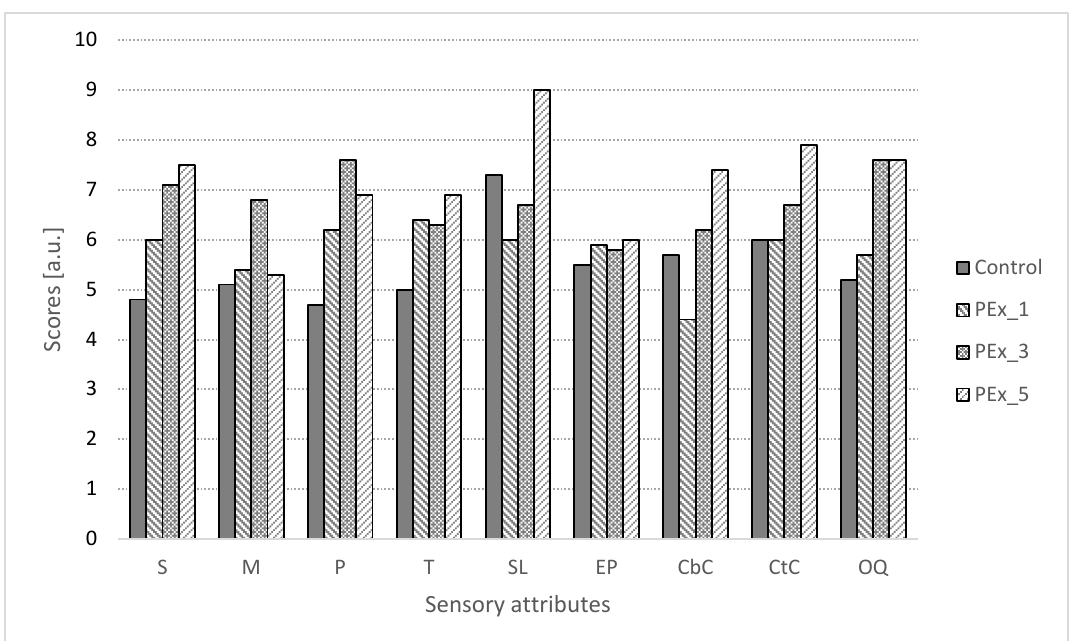
Figure 4. Scores of consumer acceptance analysis of muffins with dry PEx. Pex_1, Pex_3, and Pex_5—samples with 1, 3, and 5% replacement of flour on dry perilla extract, respectively. S—softness, M—moisture, P—porosity, T—taste, SL—smell, EP—extract’s perceptibility, CbC—crumb color, CtC—crust color, OQ—overall quality.